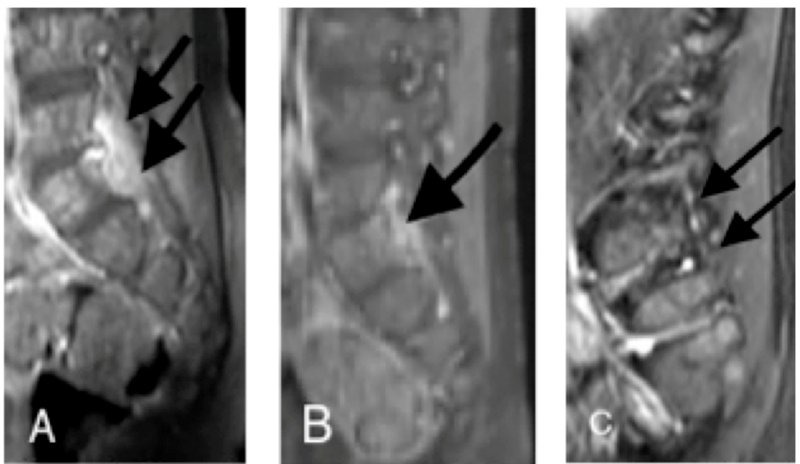
Figure 1. Lumbar spondylodiscitis with osteomyelitis, magnetic resonance imaging (MRI) of case 1. ( A ) Sagittal T1 post-enhancement image showing an increased signal of the annulus L4–L5, of the opposite end-plates of L4 and L5, of the adjacent soft tissues, and of an osteolytic area of the L5 pedicle (black arrow); ( B , C ) at the same level as A, after therapy (1 month and 4 months later, respectively), there is a progressive decrease in the pathological enhancement (black arrow), which has almost disappeared in C. Residual irregularities of the end-plates of L4 and L5 are evident.